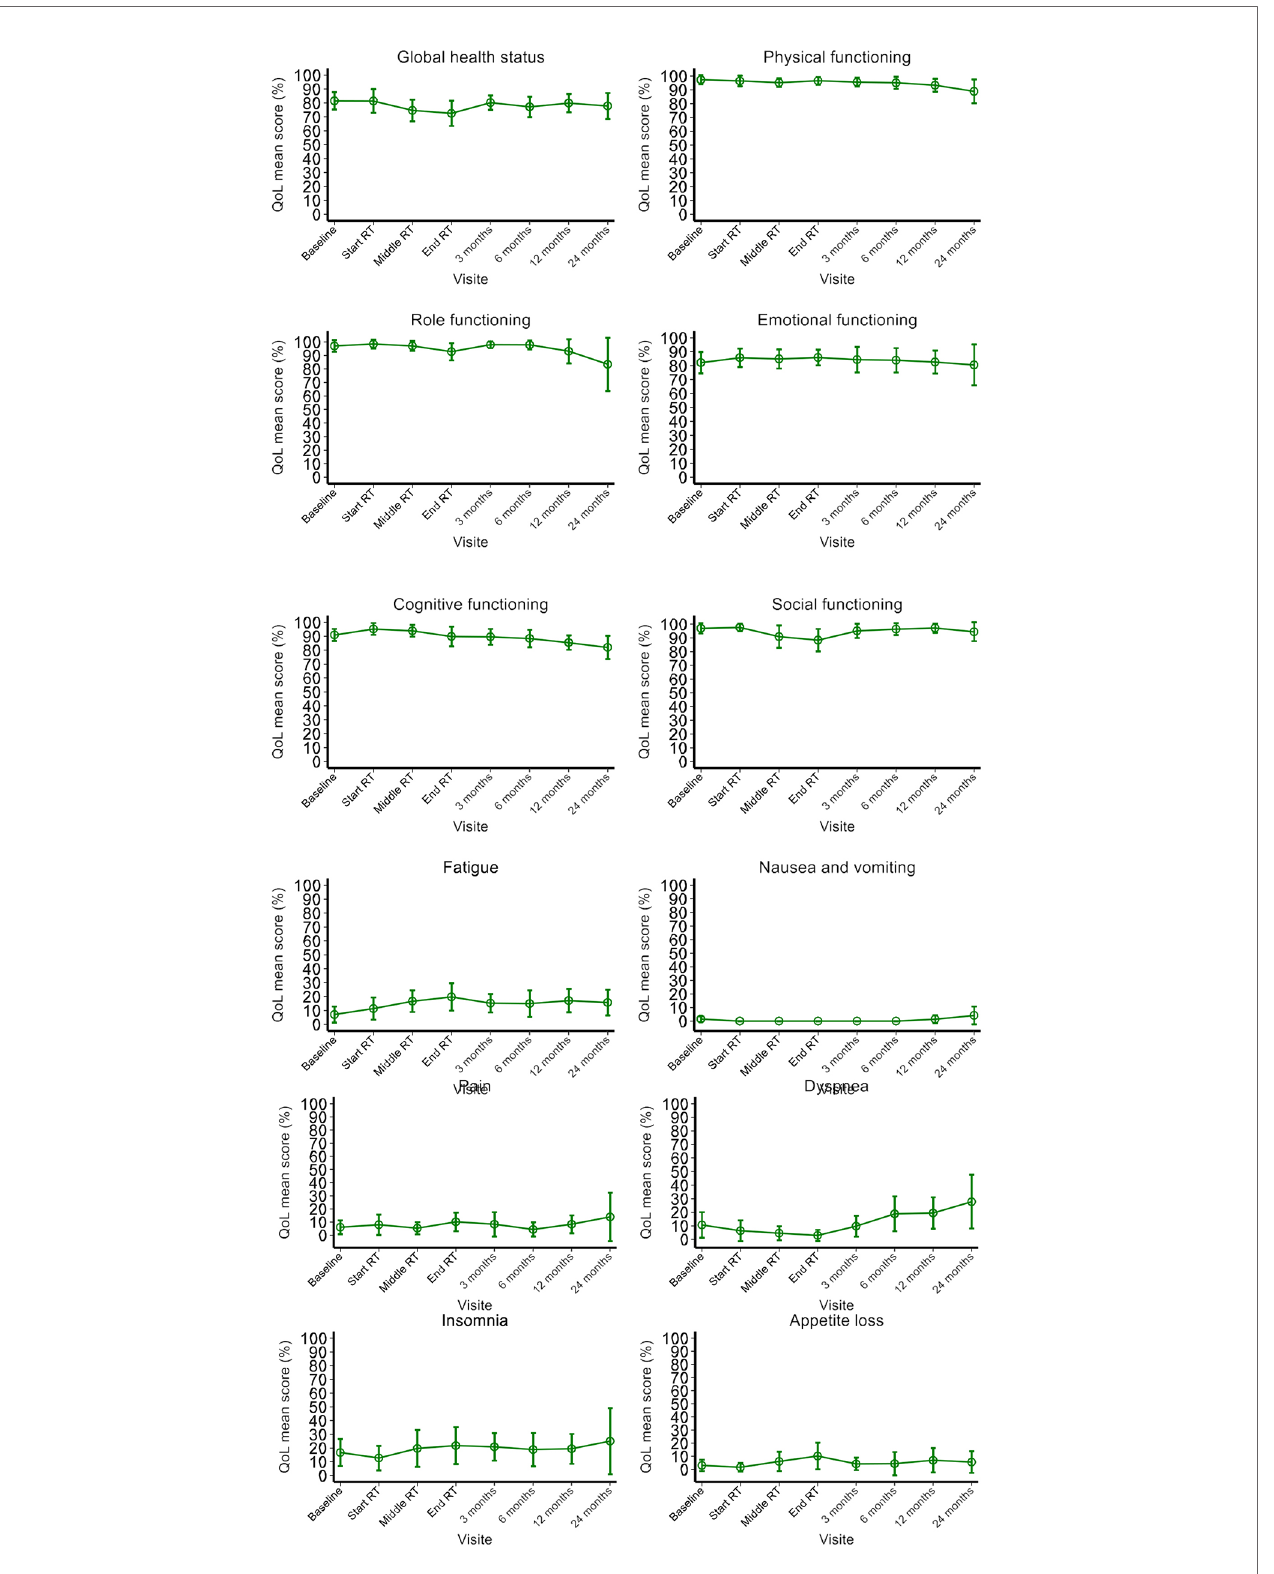
FIGURE 2 | Prostate cancer-speci fi c QoL before, during and after RT, as assessed with the EORTC QLQ-C30 and the EORTC QLQ-PR25